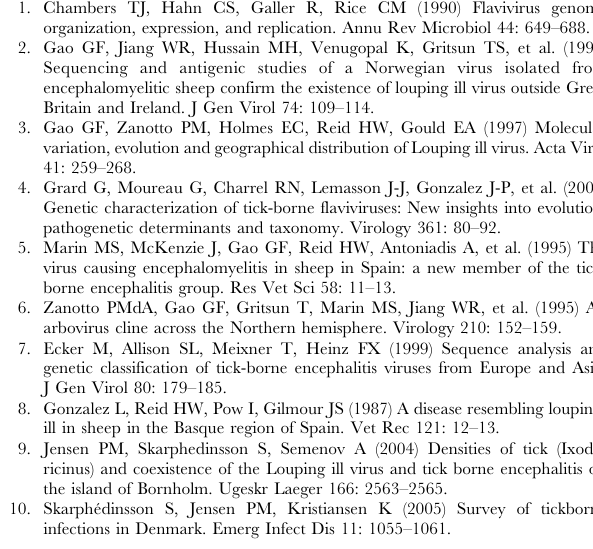
Table S1 Synoptic table of strains included in the alignments: ALN1, ALN2 and E_161. Information is provided on strain name, accession, geographical origin, year of isolation, sequence length and assigned clade.